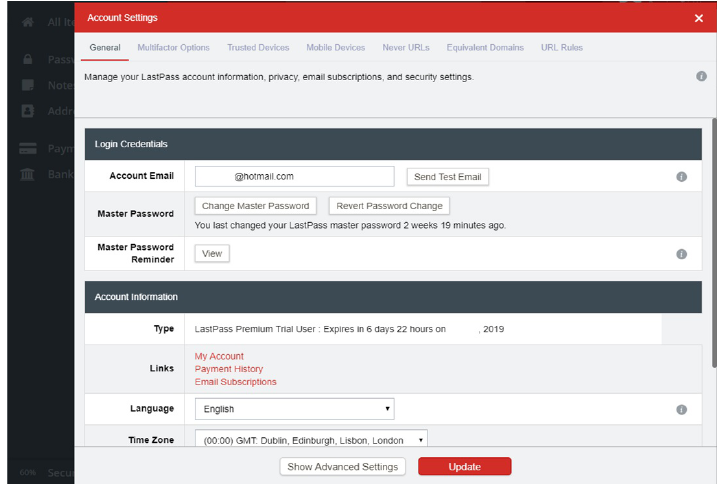
Figure A12. Colour of LastPass (Account Settings). Personal email and date are